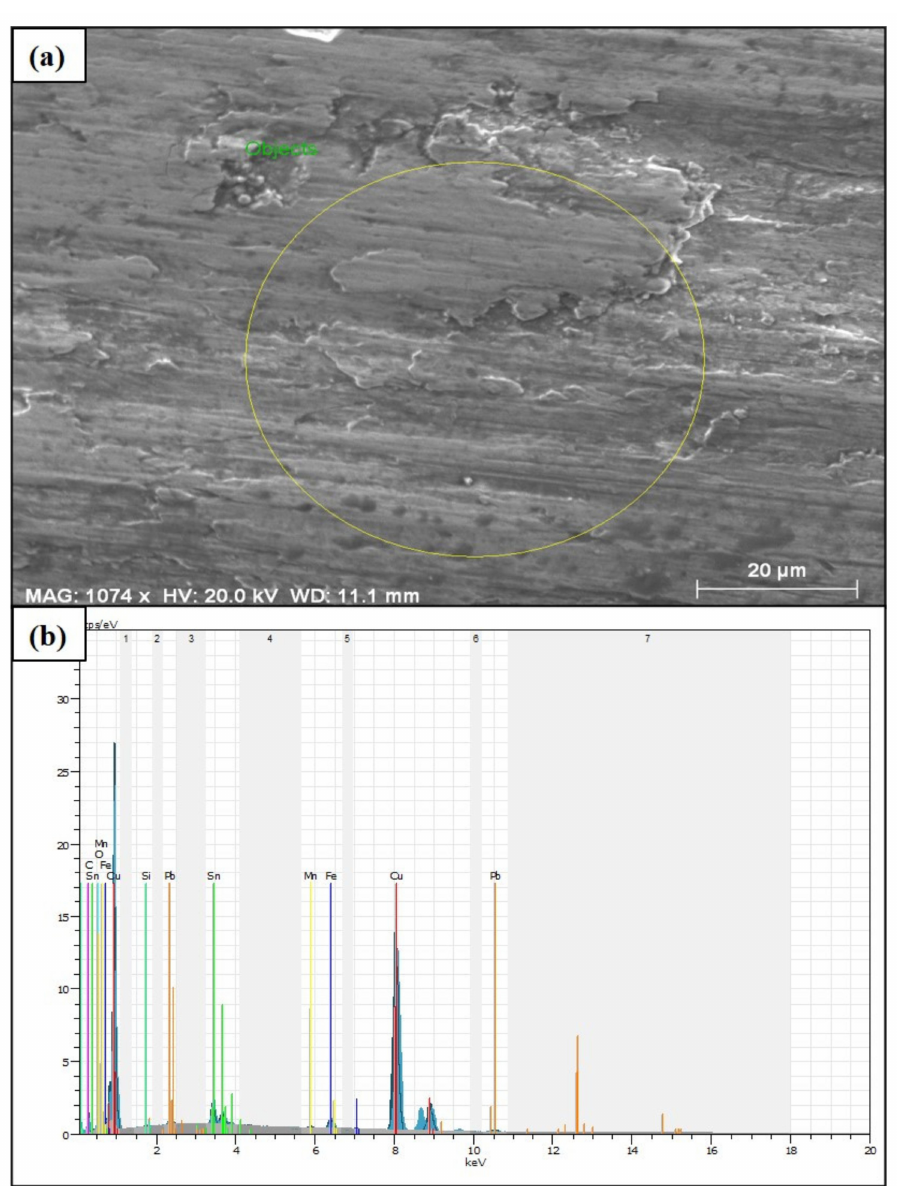
Figure 5. ( a ) SEM image of the 90B10C specimen after wear, and ( b ) corresponding EDX spectra of the selected